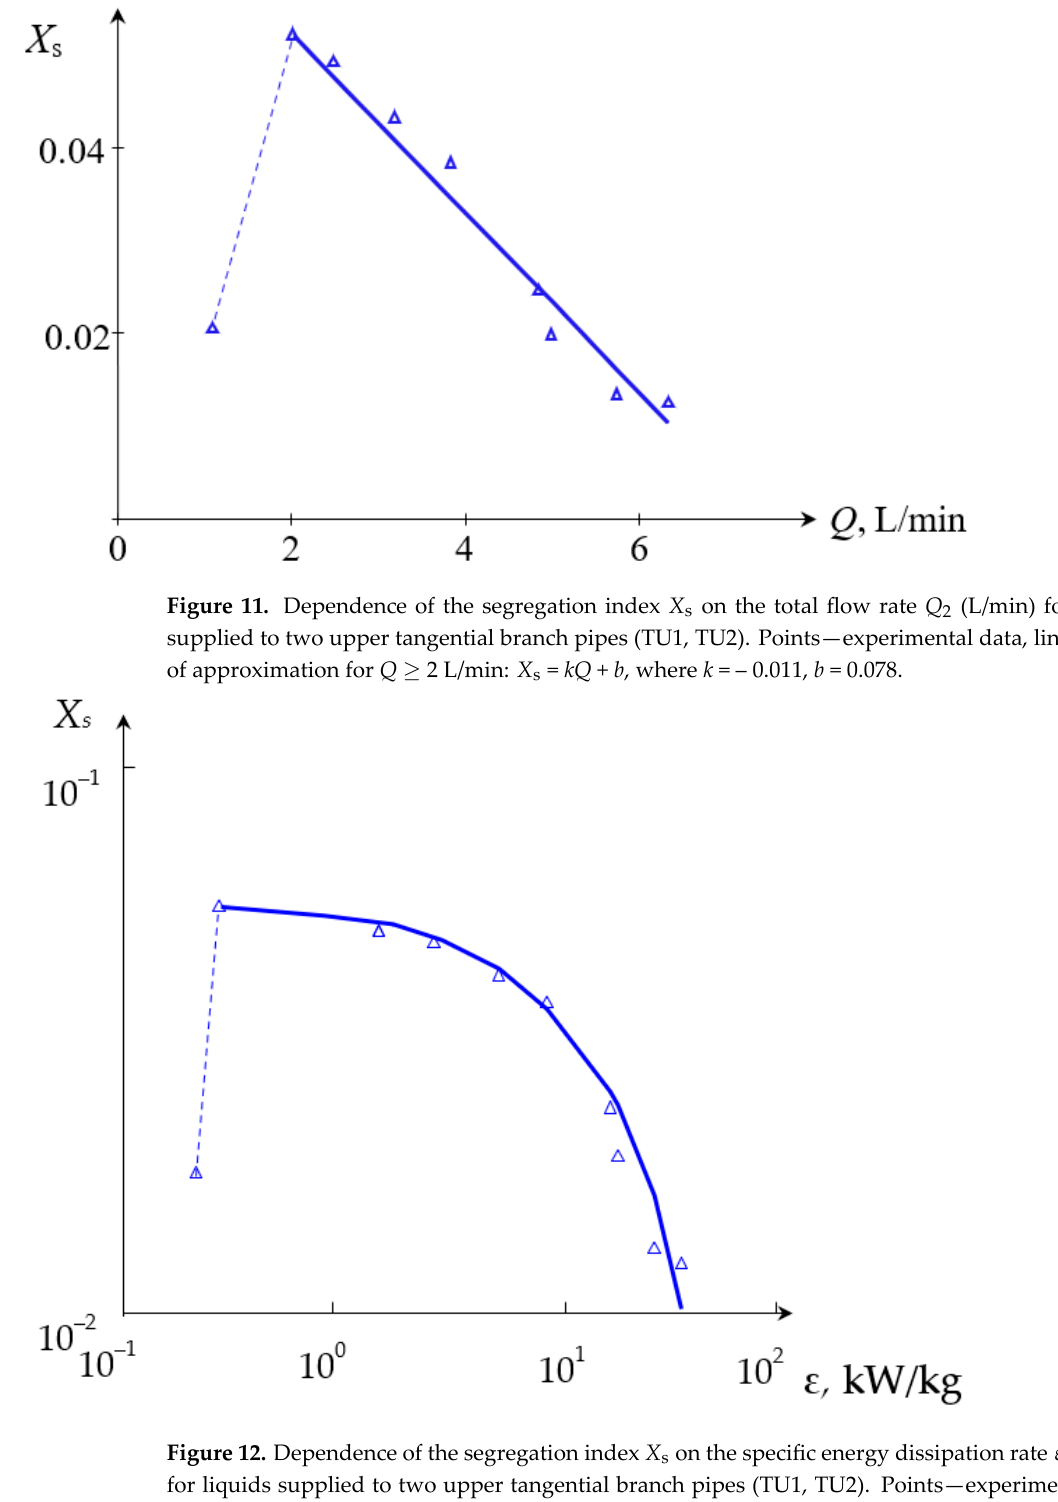
Figure 10. Dependence of the segregation index X s on the specific energy dissipation rate ε (kW/kg) for liquids supplied to the upper tangential and axial (central) nozzles. Points—experimental data, n X A   line— 3 3 , where A 3 = 4.618 × 10 − 3 , n 3 = − 0.21. s